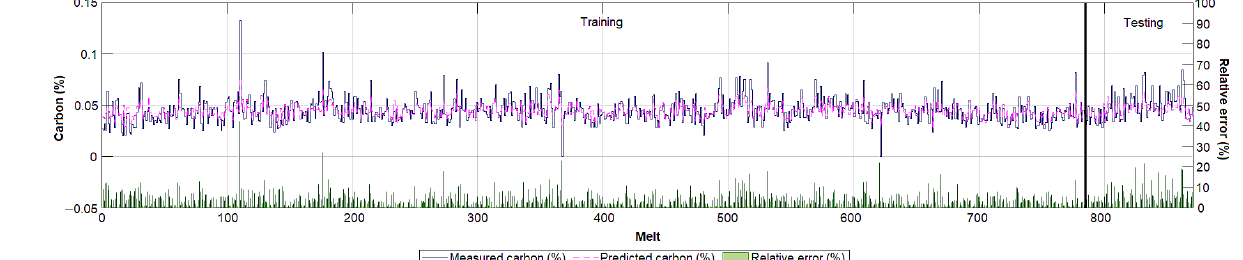
Figure 17. Prediction of endpoint carbon concentration in melt by k -NN model.